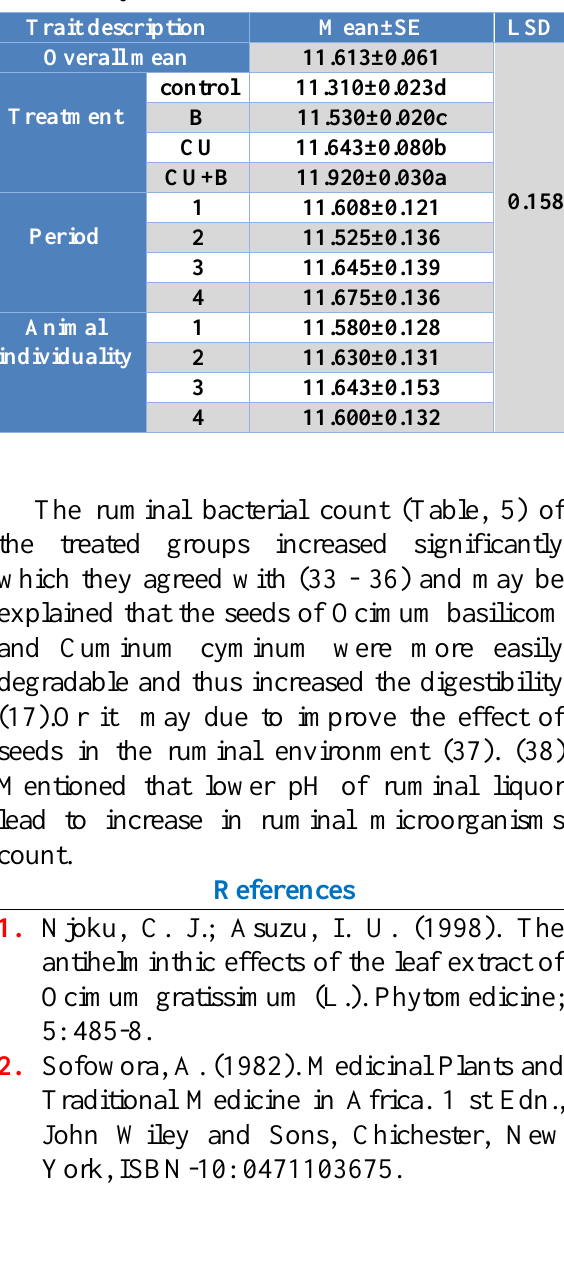
Table, 5: Effect of using Ocimum basilicum and/or Cuminum cyminum on rumen Bacterial count (CFU/ml) during different period and Awassi ram